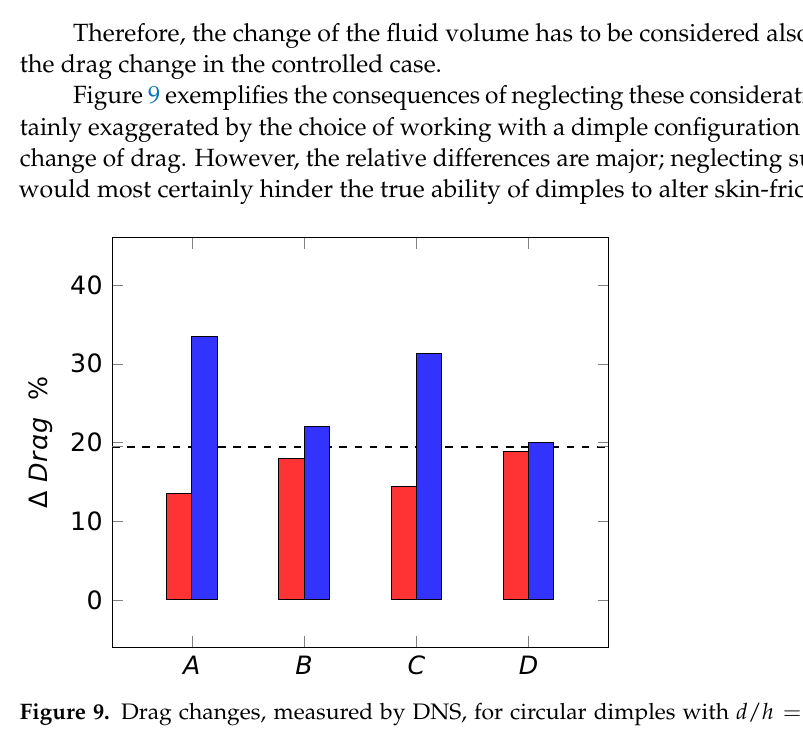
Figure 9. Drag changes, measured by DNS, for circular dimples with d / h = 0.25 at Re b ≈ 2800. Red/blue bars express drag changes when the equivalent channel defines 2 h as the distance between the top wall and the top/bottom of the dimple (color code is the same of Figure 8). Case A: comparison at the same Re b , ∆ Drag computed without accounting for the volume ratio. Case B: as case A, but ∆ Drag is corrected with the volume ratio. Cases C and D are like cases A and B, but the comparison is made at the same flow